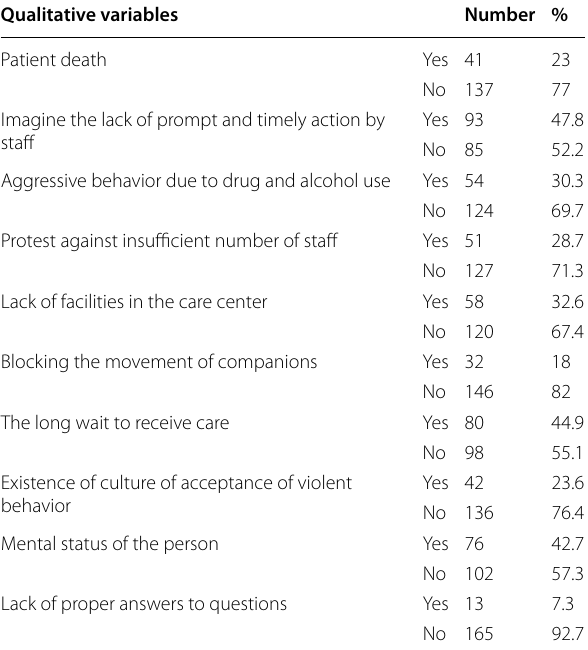
Table 2 Frequency distribution of the cause of violence in the population under study